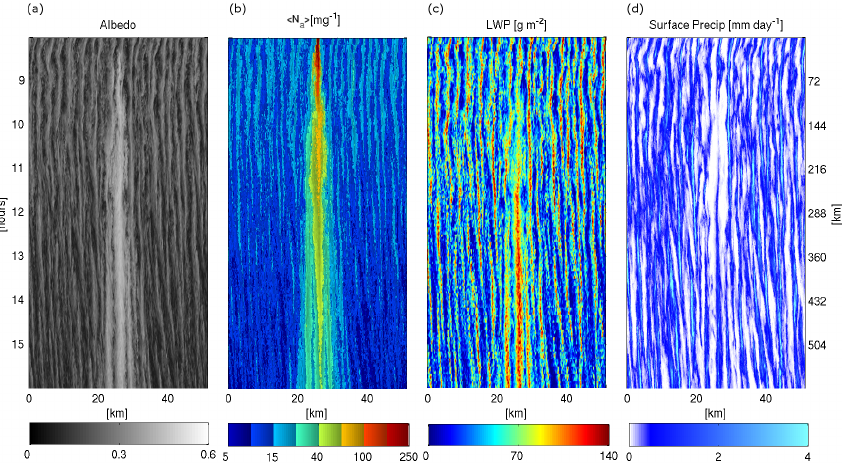
Figure 7. x – t Hovmöller plots for run BaseTrack of (a) A , (b) (cid:104) N a (cid:105) , where brackets denote a column average through the depth of the MBL, (c) LWP, and (d) surface precipitation rate. The axis on the right-hand side of the albedo plot shows the equivalent downstream distance from the ship.